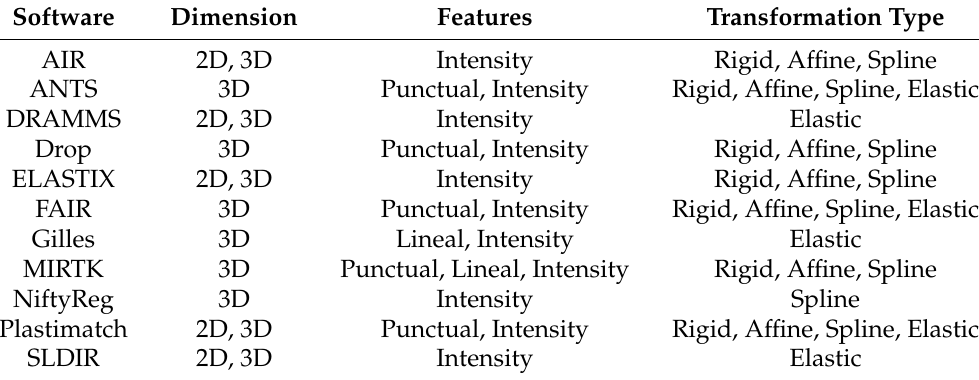
Table 1. Most popular positron emission tomography (PET) image statistical reconstruction algo- rithms and their main features.